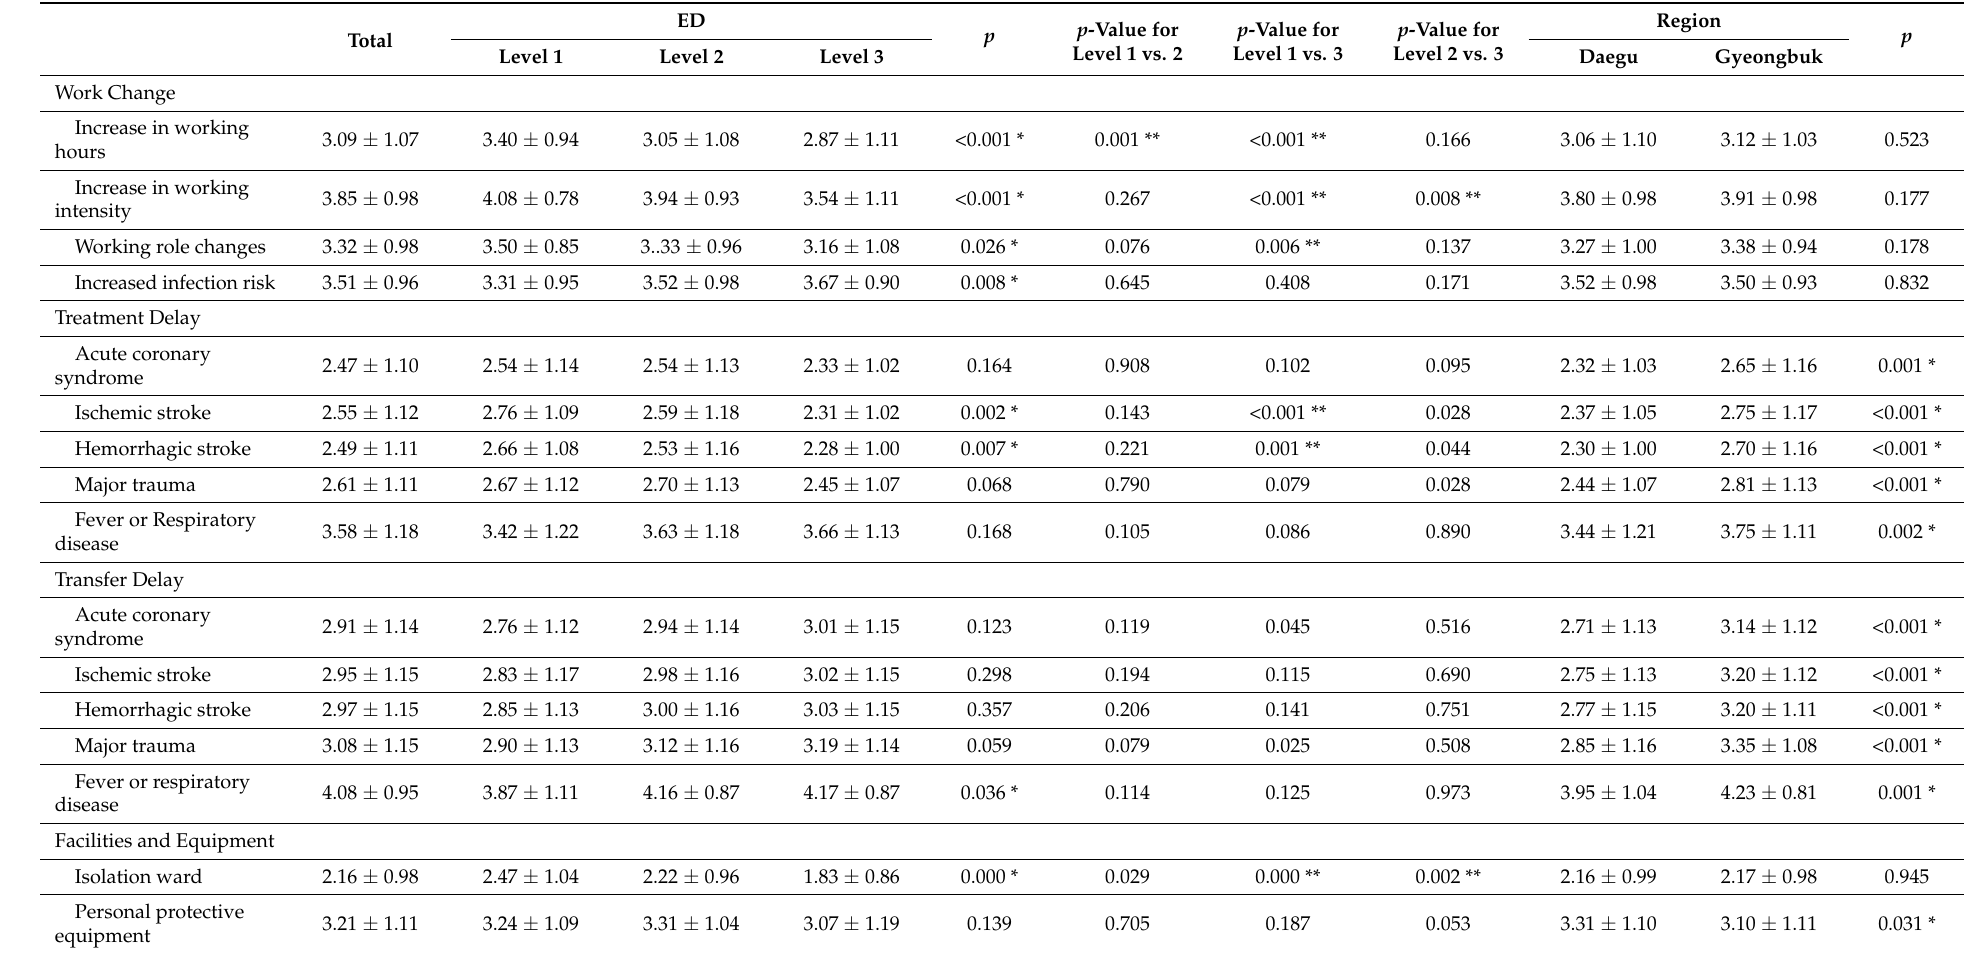
Table 2. Changes in working conditions during the COVID-19 pandemic by ED and